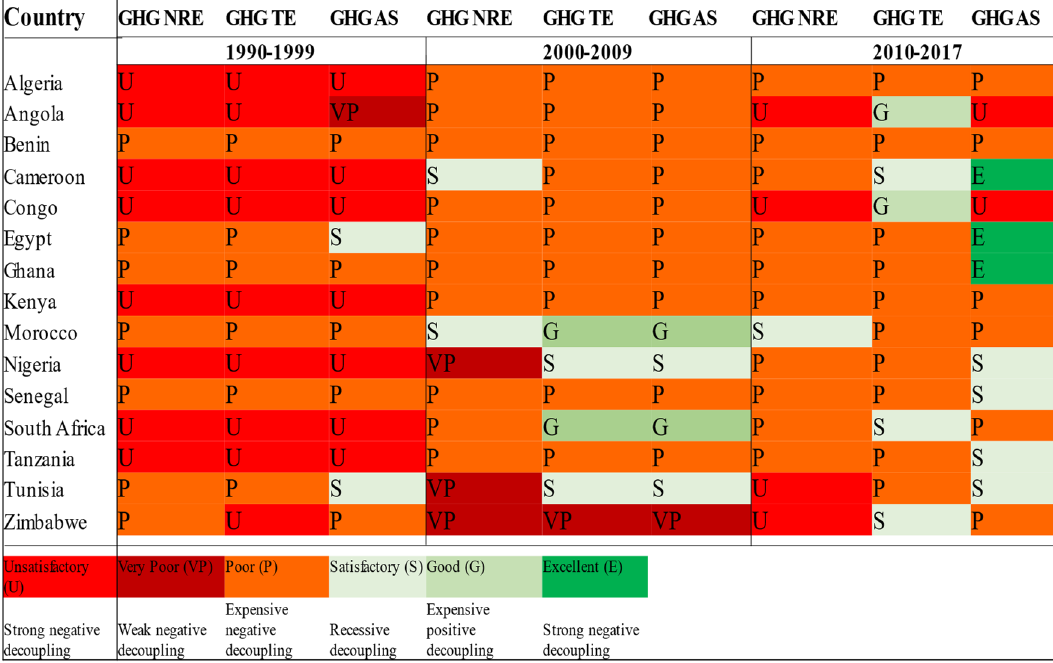
Figure 5. EWF’s GHG footprint-Food GHG footprint (source calculated by equation 7).